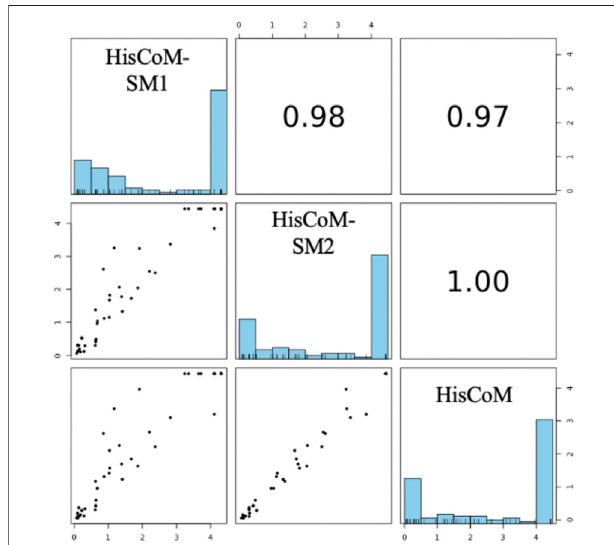
FIGURE 3 | Pairwise scatter plot of 101 pathways ’ FDR q-values calculated by HisCoM-SM methods and HisCoM using metabolite. Note that His-CoM-SM1 represents HisCoM-SM(single) and HisCoM-SM2 represents HisCoM-SM(GBLUP).